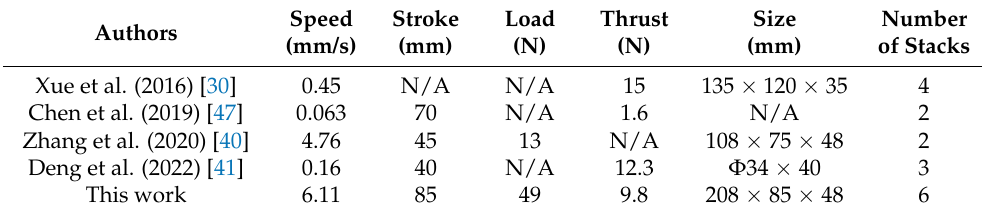
Table 3. Performance comparison of stepping piezoelectric